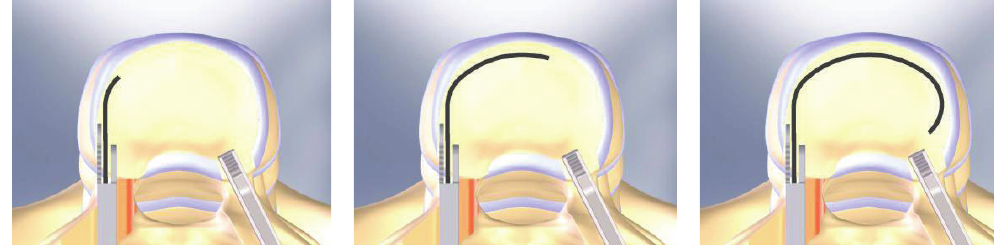
Figure 2: Implantation technique.